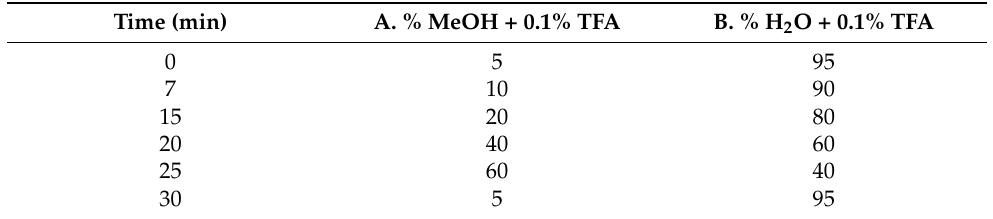
Table 1. Timetable for the HPLC elution of PRE, using a binary gradient elution